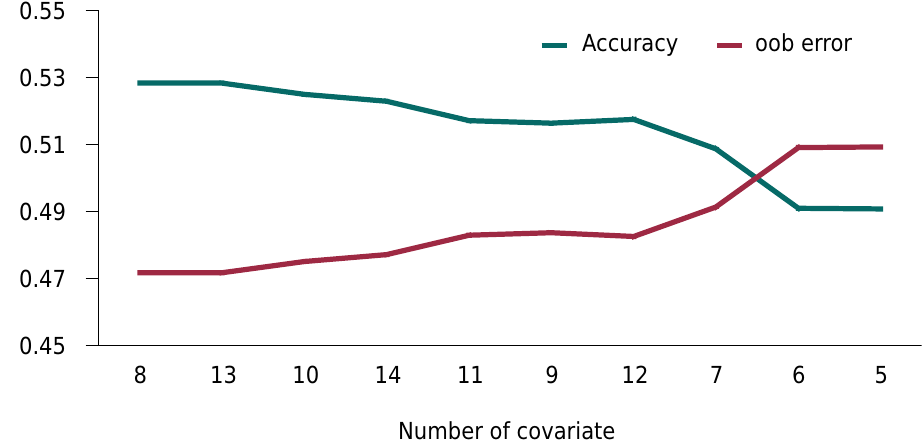
Figure 4. Overall accuracy and oob error per group of predictor covariates selected using RFE.